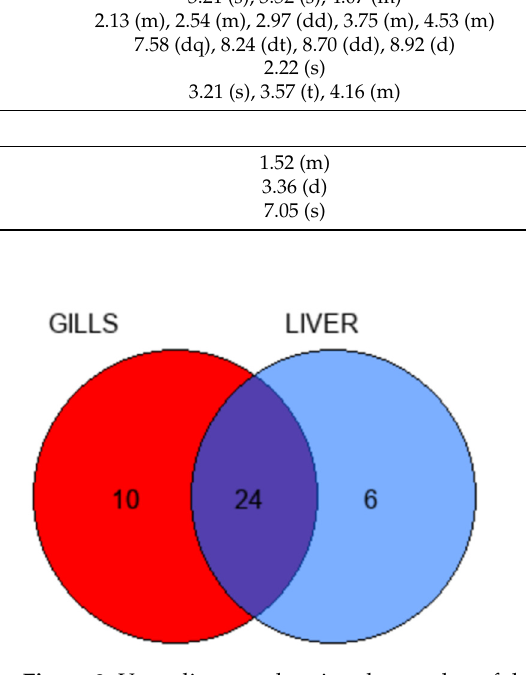
Figure 3. Venn diagram showing the overlap of the metabolites that were detected in the gills and liver of fish that were collected from the reference area. Table 2. Metabolite comparison between the gills and liver of golden grey mullet ( C. auratus ) that were sampled from the reference area São Jacinto (SJ), northwest coast of Portugal.